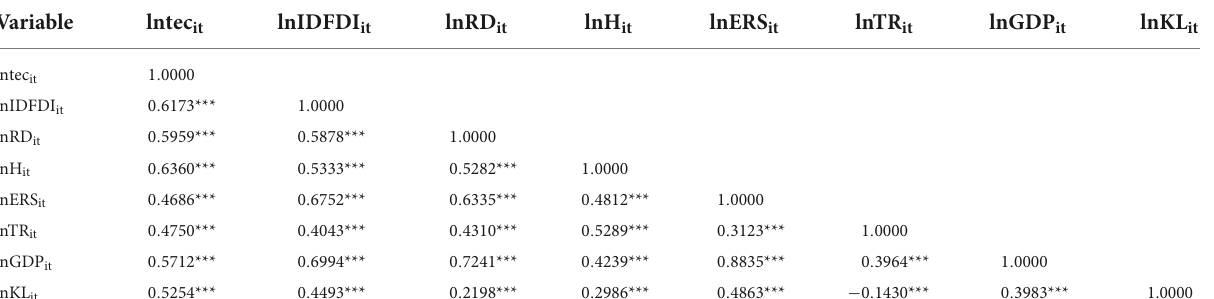
TABLE 5 Correlation matrix.